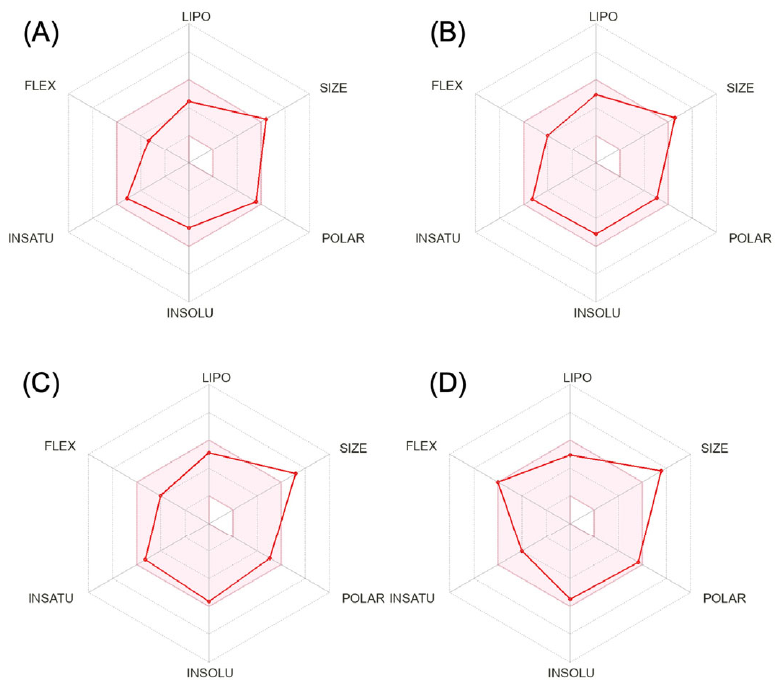
Figure 1. Physicochemical properties of rimegepant ( A ), ubrogepant ( B ), atogepant ( C ), and zavegepant ( D ).